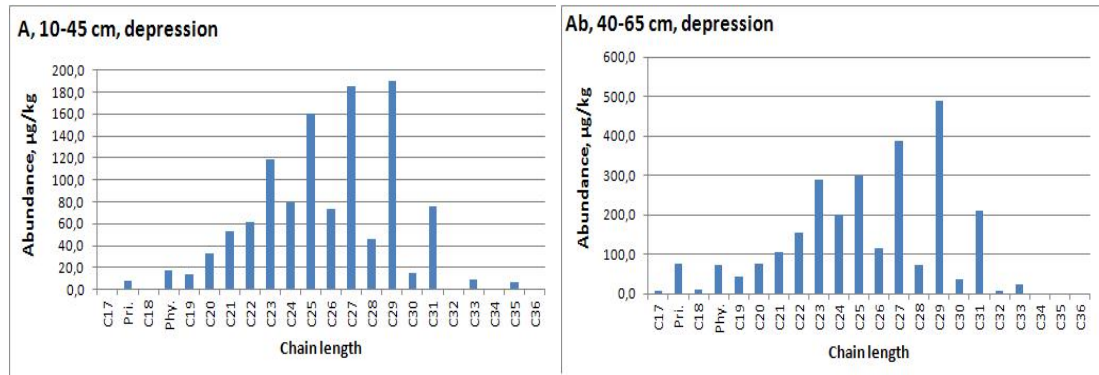
Figure 6. n ‐ Alkane distribution in soil with second humus horizon (Ab) of micro ‐ depression and Figure 6. n -Alkane distribution in soil with second humus horizon (Ab) of micro-depression and Geosciences 2020 , 10 , 86 interstadial soil from loess ‐ paleosol sequence under it. interstadial soil from loess-paleosol sequence under it.